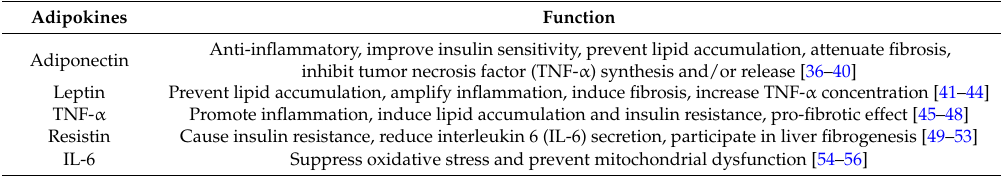
Table 1. Major adipokines involved in nonalcoholic fatty liver disease (NAFLD) pathogenesis.